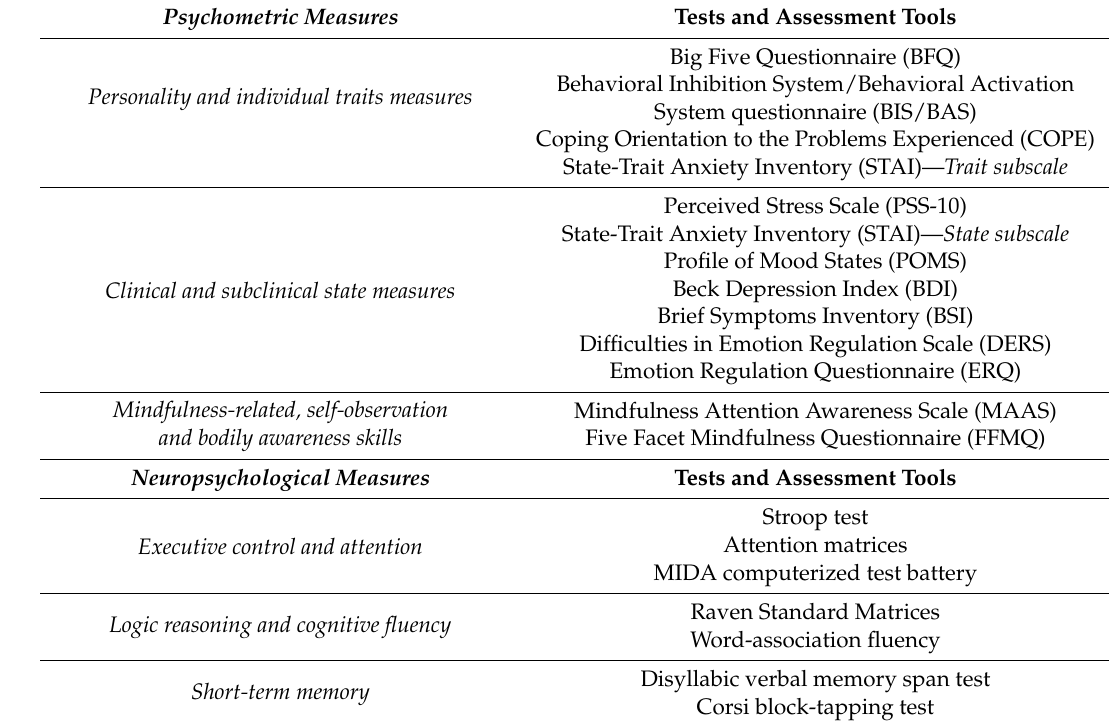
Table 1. Complete battery of psychometric and neuropsychological tests that was administered during assessment